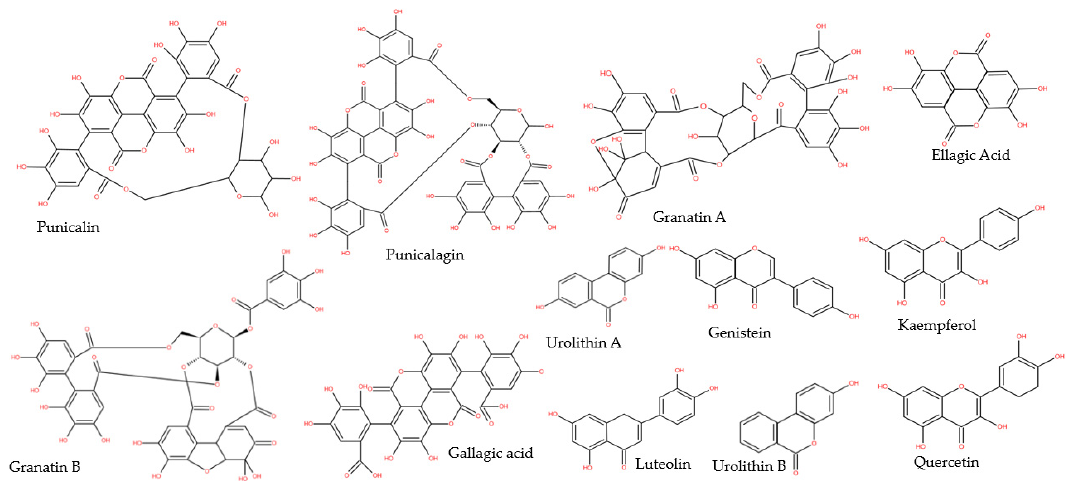
Figure 5. Chemical structures of the most common bioactive molecules isolated from pomegran- ate.